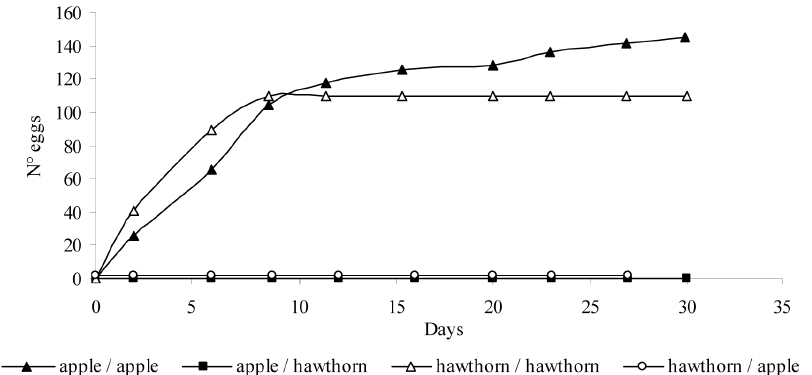
Figure 1. Oviposition of Cacopsyllamelanoneura . Mean cumulative numbers (untransformed data) of eggs laid by the two samples of Cacopsylla melanoneura on the two host plants.